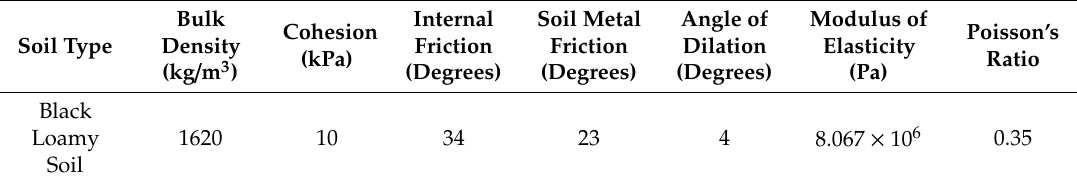
Table 1. Soil Mechanical Properties.